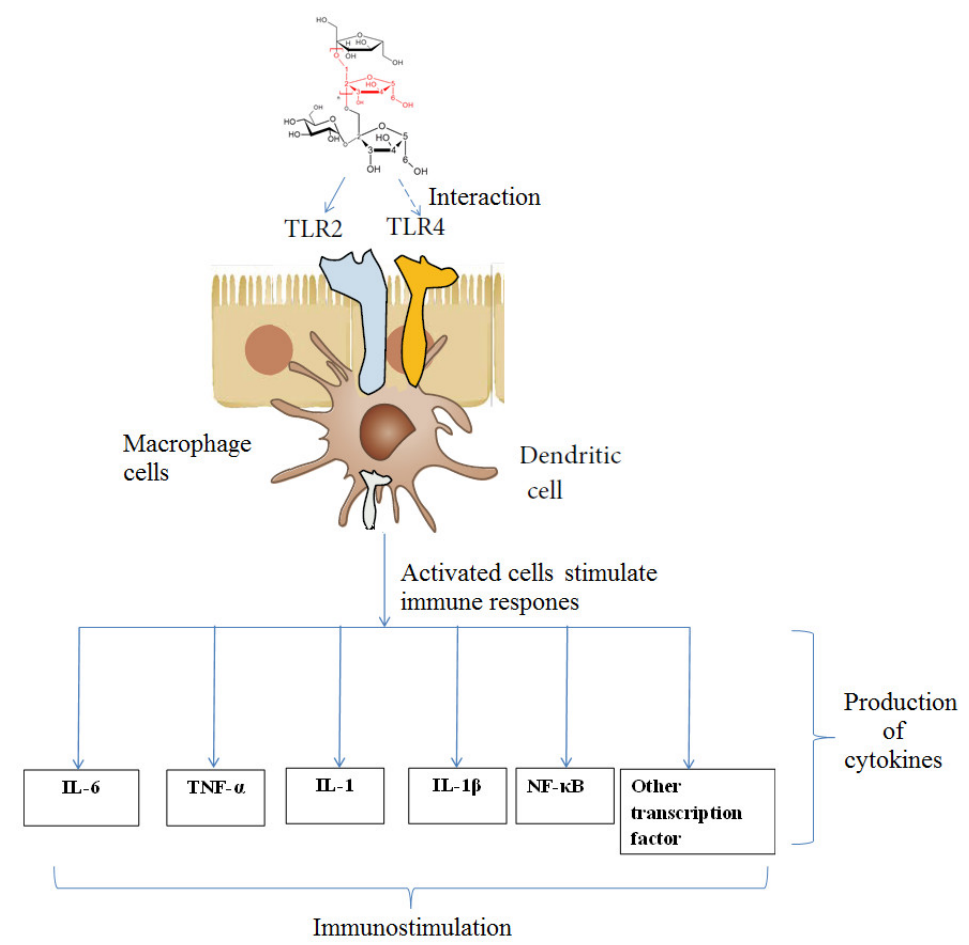
Figure 7. Schematic representation of mechanism of immunostimulatory activity induced by inulin- type fructans (β-D-(2 → 1)-fructan) of longer chain lengths (Note: Fructans with shorter chains leads to decreased production of cytokines) [40,41].